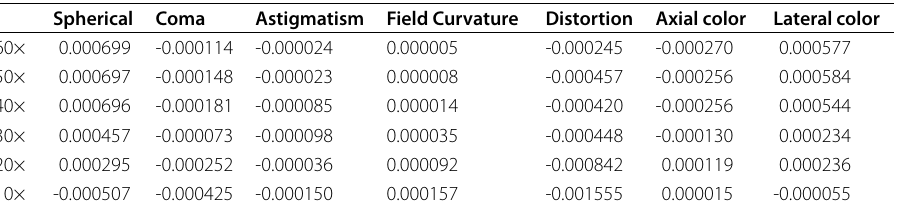
Table 3 Variation of the chromatic aberration with the magnification